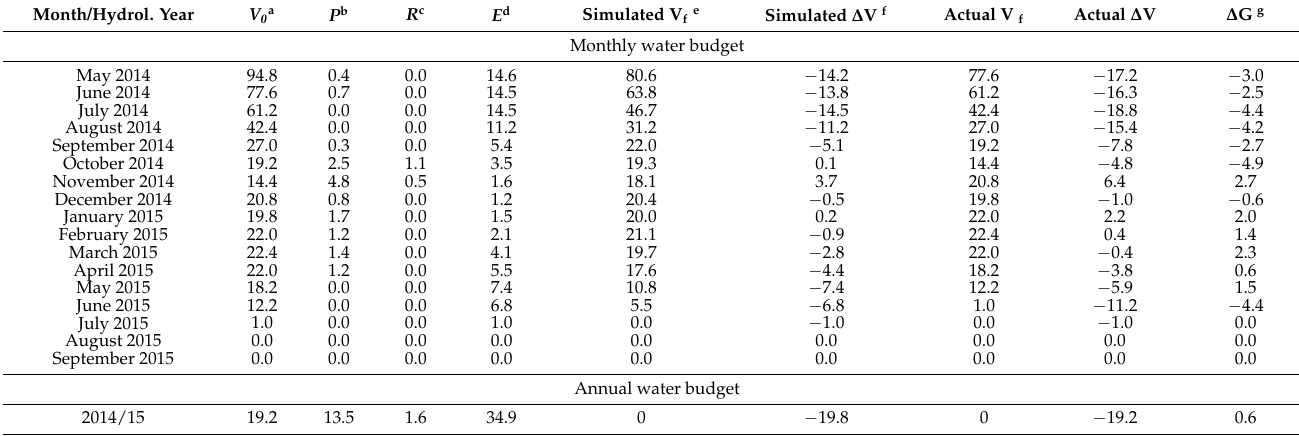
Table 2. Monthly and annual water budget of the Jarales wetland in the study period. Units in dam 3 . Month/Hydrol.